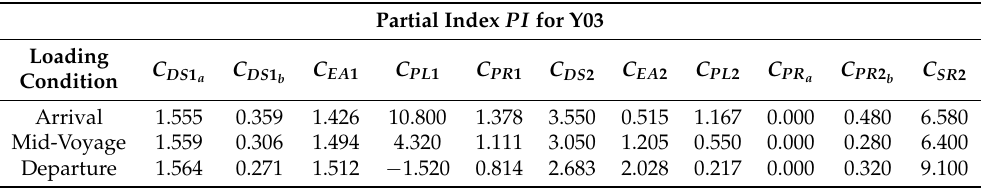
Table 8. Partial index, taking into account stability in waves performance of Y03. Values of si equal to or lower than 1.0 means the loading condition is compliant with the